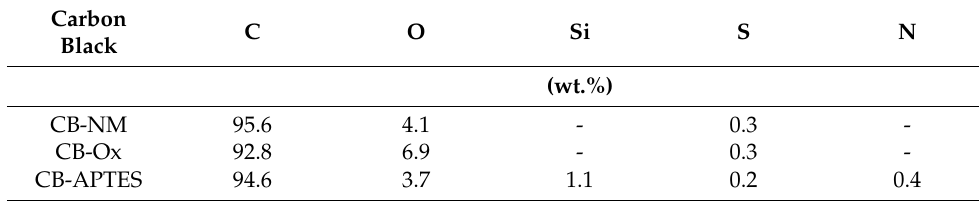
Table 3. The EDS analysis results of the carbon black samples. Carbon Black